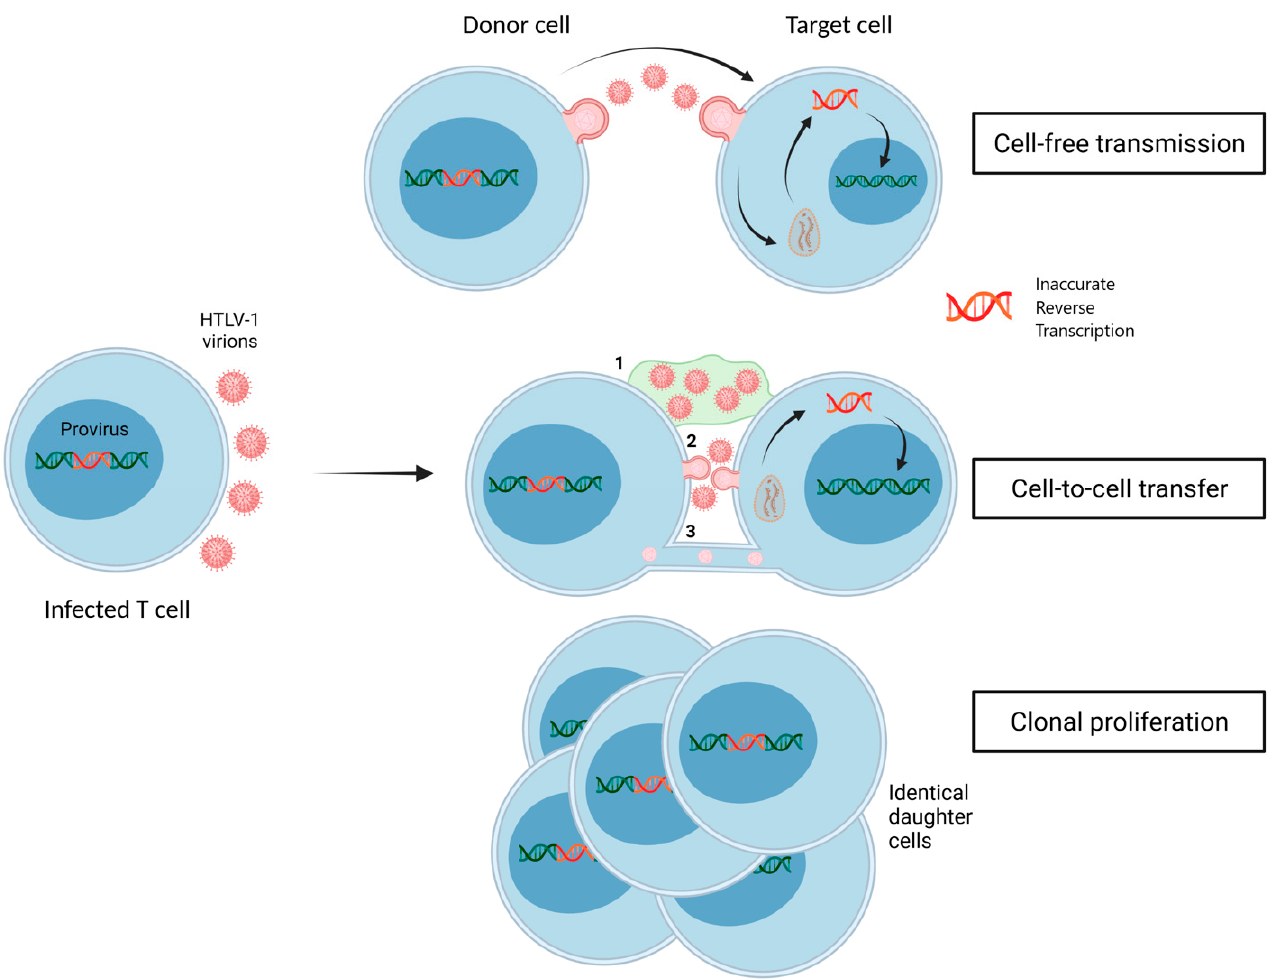
Figure 1. Modes of HTLV-1 dissemination. The donor cell is an infected CD4+ T cell containing a stably integrated provirus. In vitro cultures of infected cells produce low numbers of virions that are poorly infectious. Thus, cell-free transmission is not considered as an efficient mode of dissemina- tion of HTLV-1, in contrast to other viruses such as HIV. Viral dissemination upon infectious spread instead occurs through cell-to-cell contacts using a biofilm (1), viral synapses (2) or protrusions and